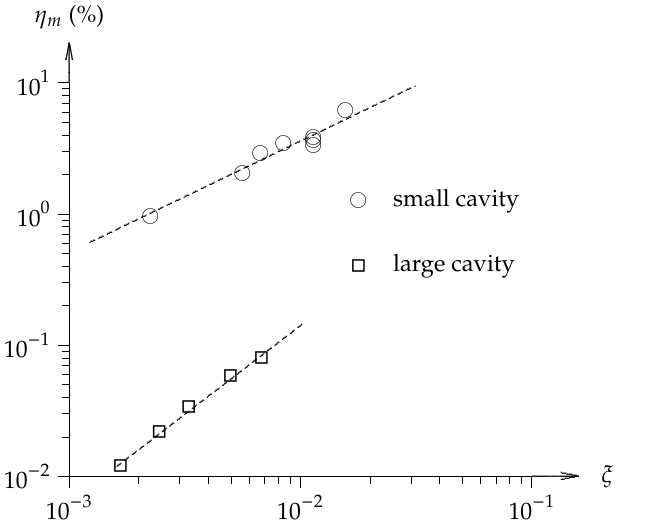
Figure 30. Efficiency versus dimensionless heating volume. Figure 28. Efficiency versus dimensionless heating